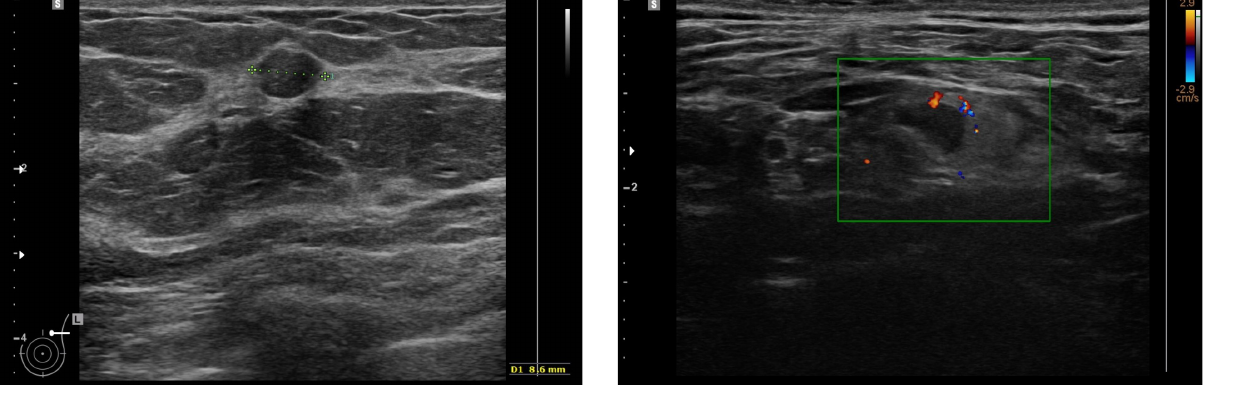
Fig. 3. Small metastatic lymph node with abnormal L/T ratio (verified by core biopsy).